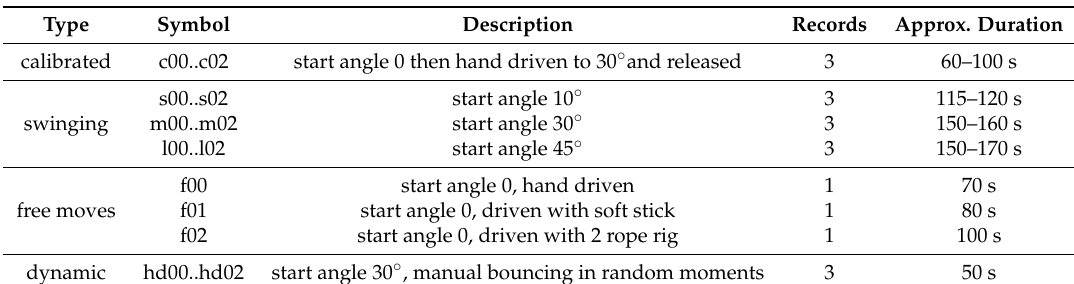
Figure 8. The pendulum with attached IMUs during the tests in the HML - motion capture laboratory. Table 2. Recorded scenarios of pendulum